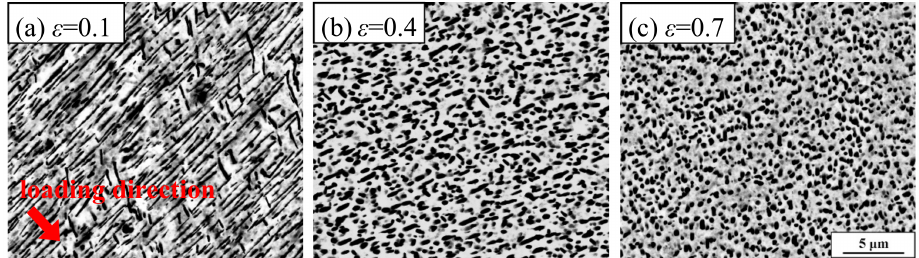
Figure 7. Microstructures of Ti-55531 after a compressive strain of ( a ) 0.1; ( b ) 0.4; and ( c ) 0.7 at 750 ◦ C /10 − 3 s − 1 .